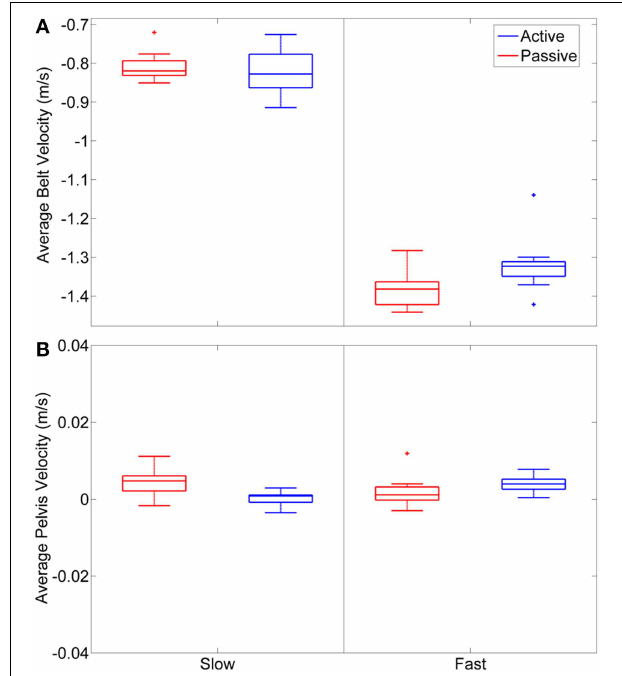
FIGURE 3 | (A) Average belt velocity, measured as foot velocity during stance phase, for slow and fast walking commands in passive and active mode across the 9 subjects. (B) Average sagittal plane pelvis velocity during the treadmill walking tasks.